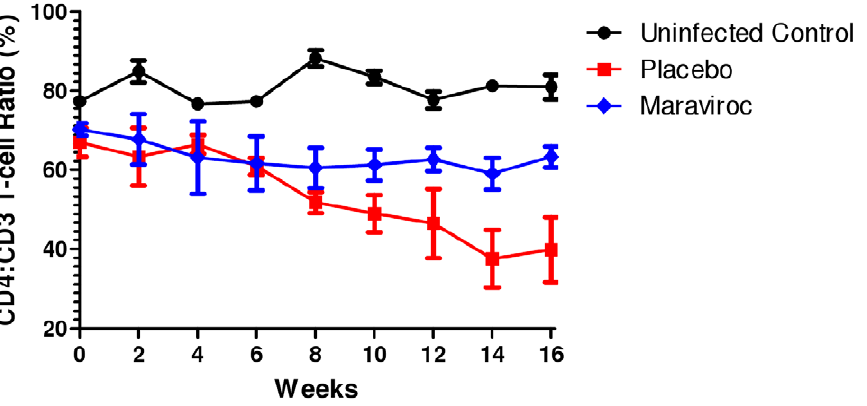
Figure 3. CD4 T cell decline in non-treated vaginally challenged mice in contrast to mice protected with maraviroc gel. Levels of CD4 T cells were monitored on a weekly by FACS basis to determine their decline in treated versus non-treated mice. Baseline values for each of the mice were established prior to infection as described in Methods.